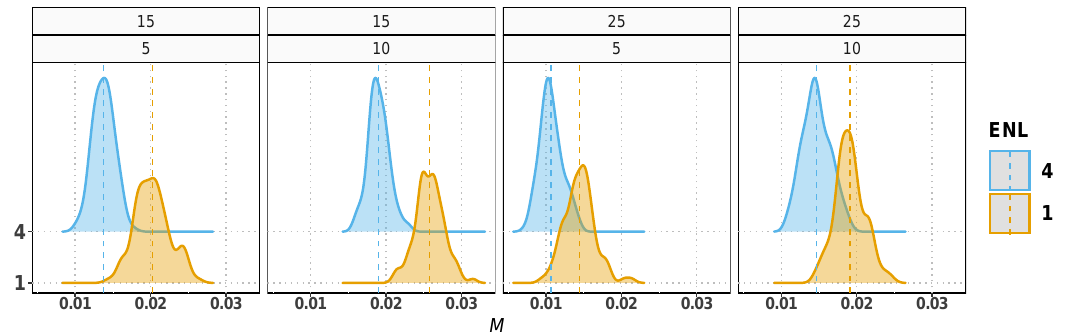
when applied to pure speckle without structure. M is without H 0 M